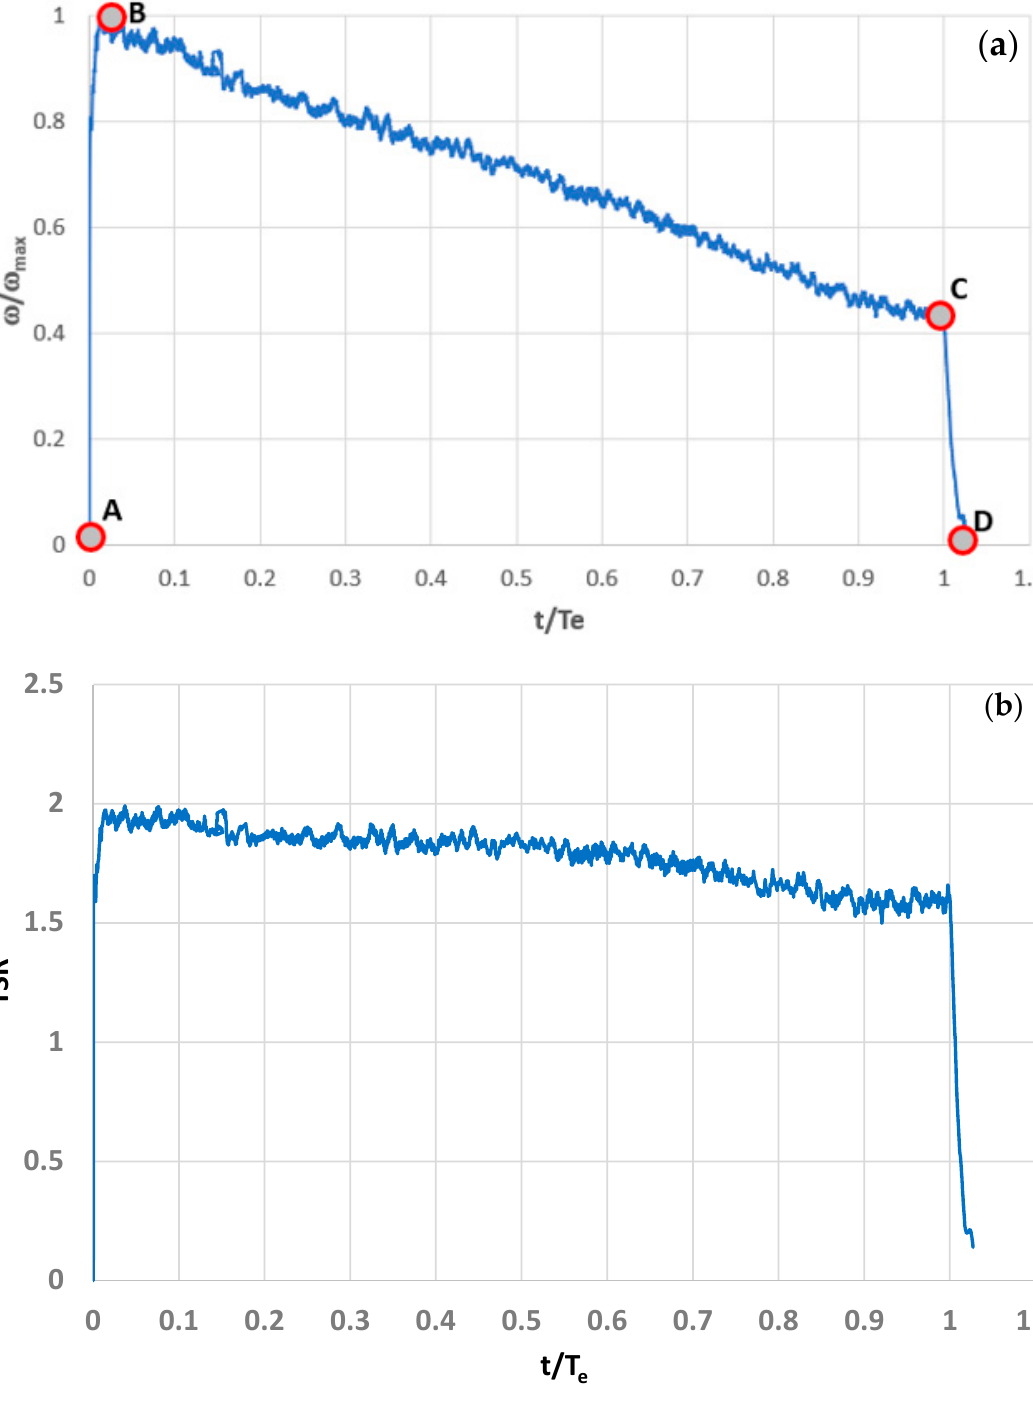
Figure 8. Video analysis measurements of the temporal variations of ( a ) the normalized rotor’s angular speed and ( b ) the tip speed ratio (TSR).